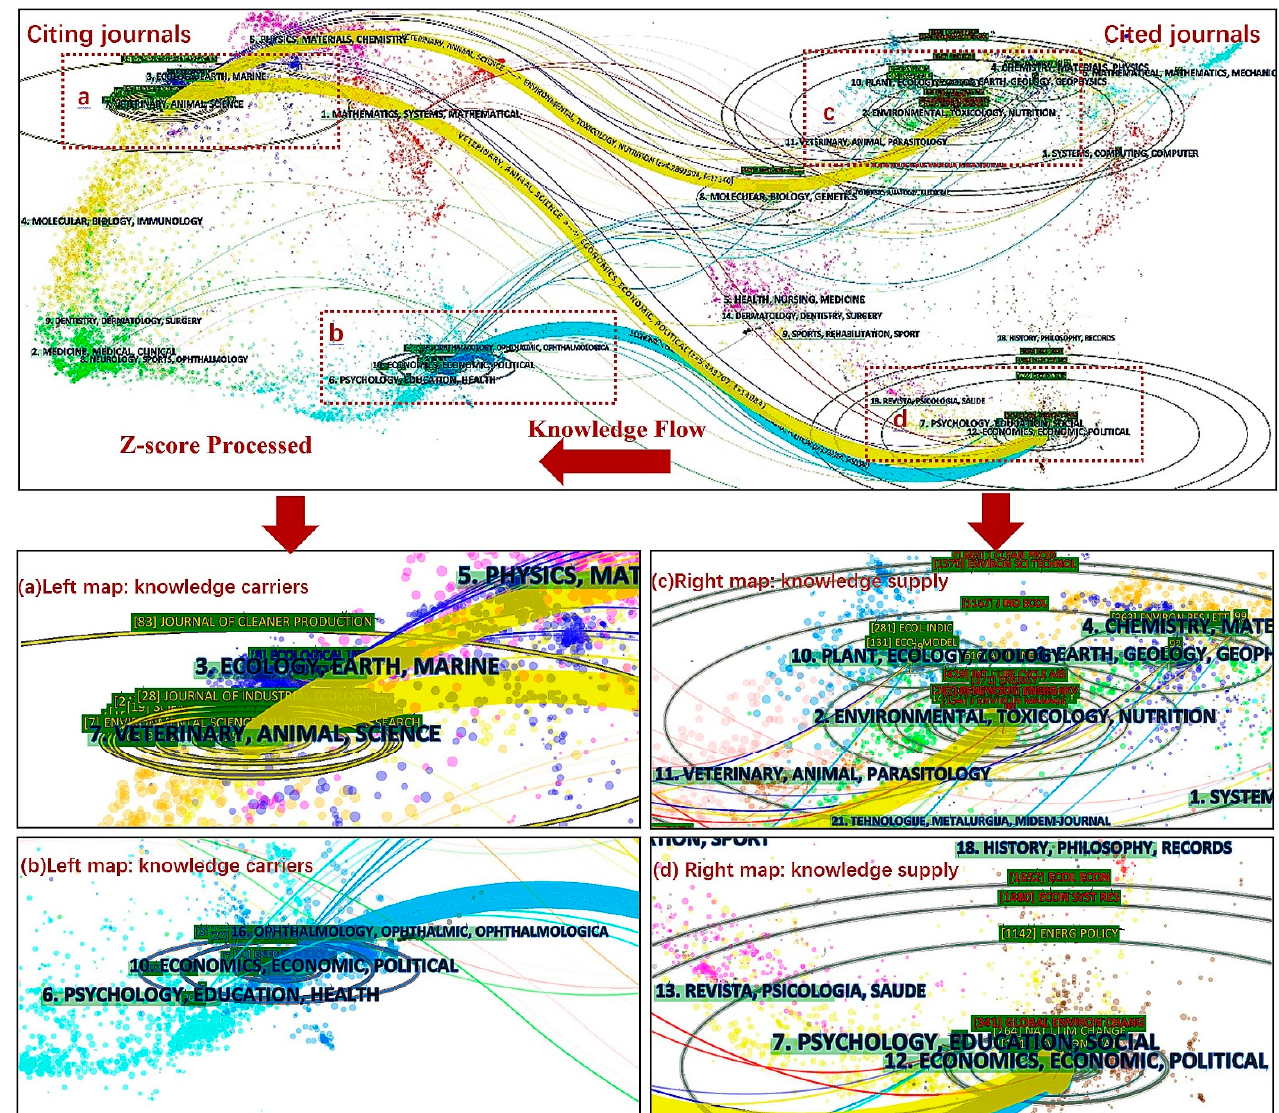
Figure 6. Dual-map overlay graph of journals and disciplines after Z-score processing( top ); detail in enlarged scale ( bottom ): knowledge carriers ( a , b ), knowledge supply ( c , d ).